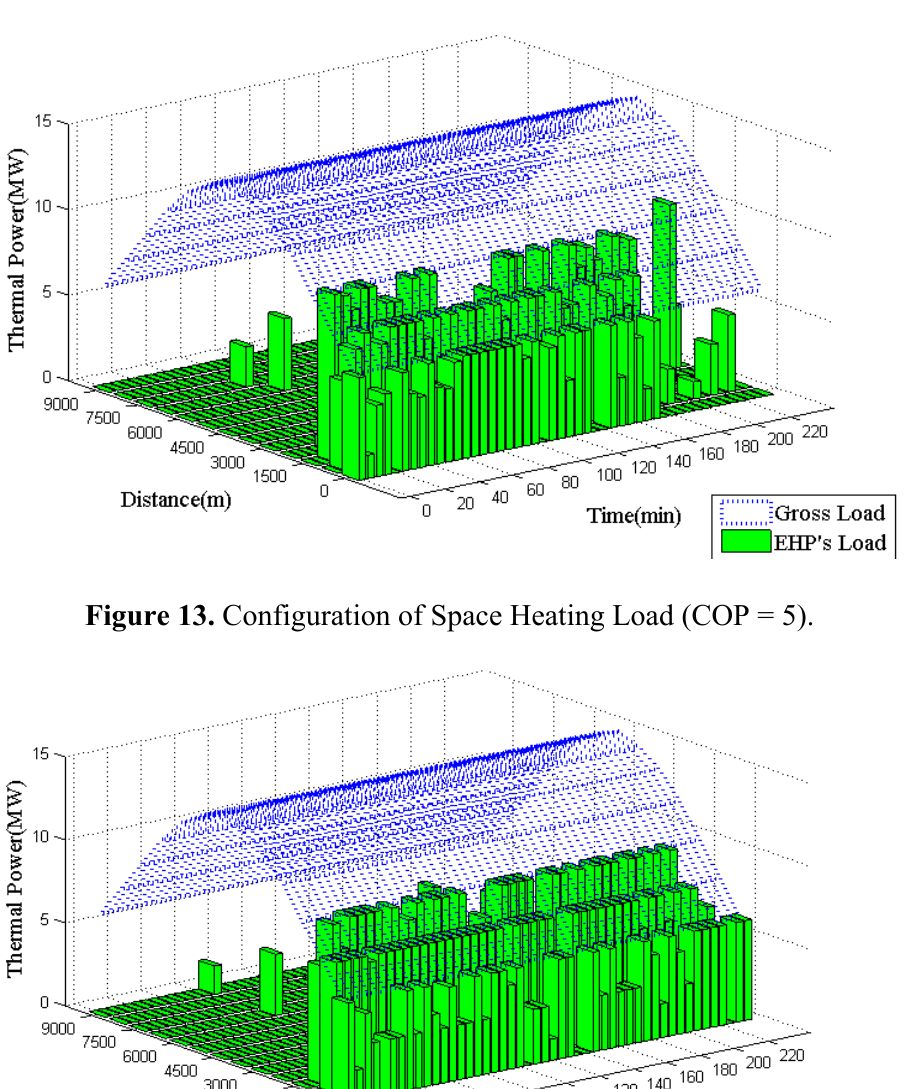
Figure 12. Configuration of Space Heating Load (COP = 4).